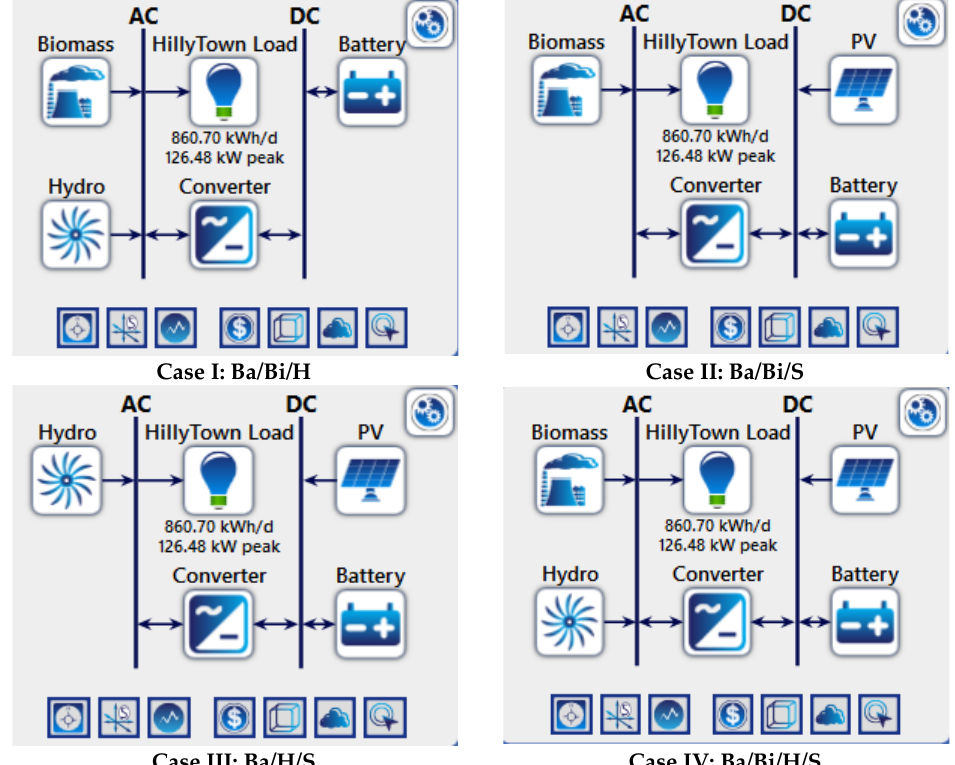
Figure 9. Four different autonomous renewable-based IES cases considered for the studied location.